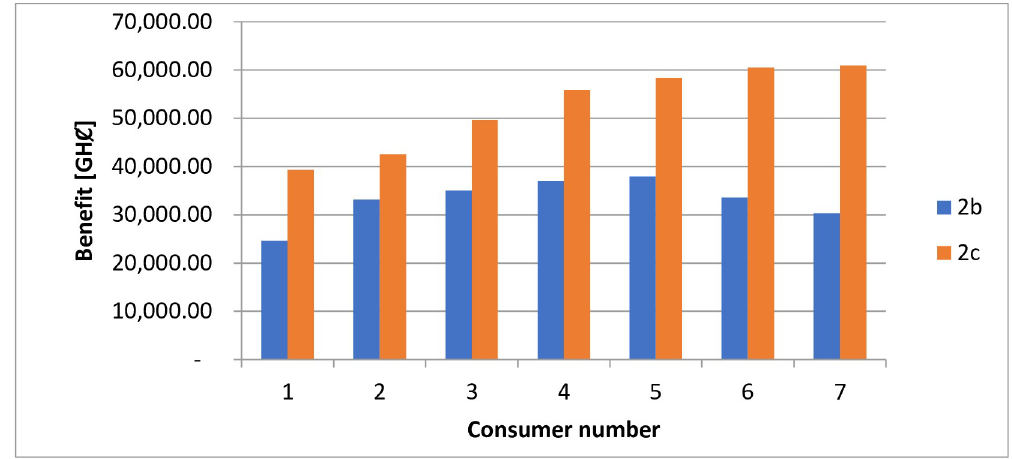
Fig 11. Incentives paid to consumers per day–case 2.